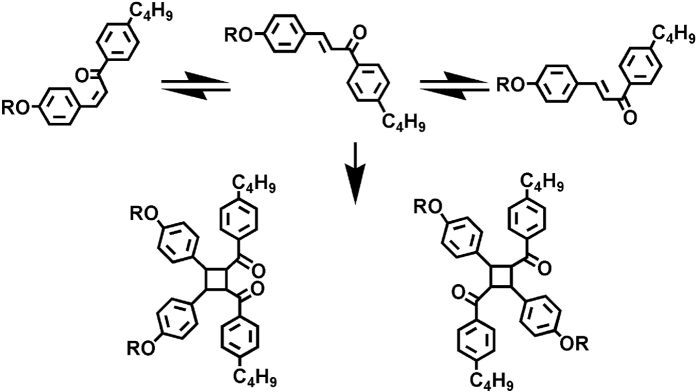
Photochemical Reaction of the chalcone under UV irradiation forming “Head to Head” and “Head to Tail” structures49.